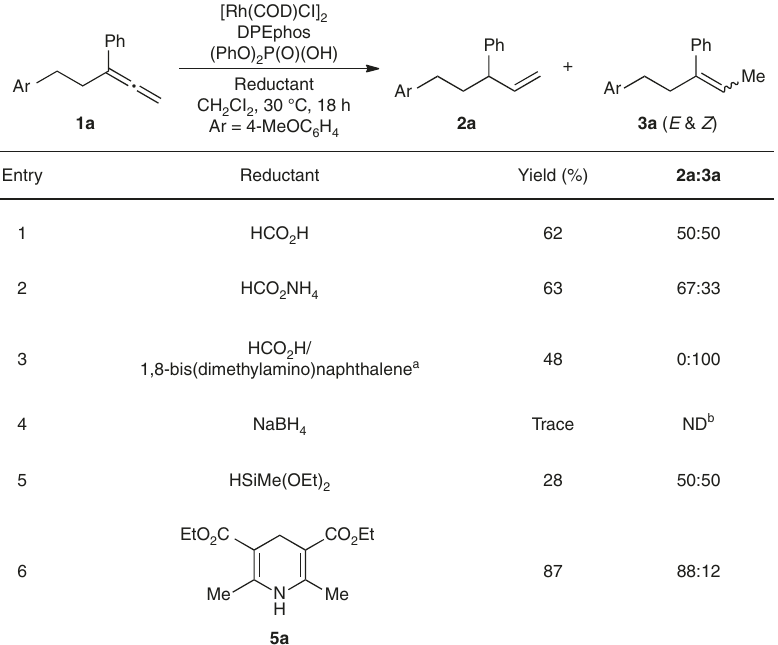
Fig. 2 Evaluation of reductants. Reaction conditions: 1a (0.050mmol), reductant (0.10 mmol), [Rh(COD)Cl] 2 (4 mol%), DPEphos (8 mol%), (PhO) 2 P(O) (OH) (8 mol%), CH 2 Cl 2 (0.1 mL), 30 °C, 18 h. Yields and regioselectivities were determined by 1 H NMR analysis of the unpuri fi ed reaction mixture using dimethyl terephthalate as an internal standard. a HCO 2 H (0.11 mmol), 1,8-bis(dimethylamino)naphthalene (0.060 mmol). b ND, not